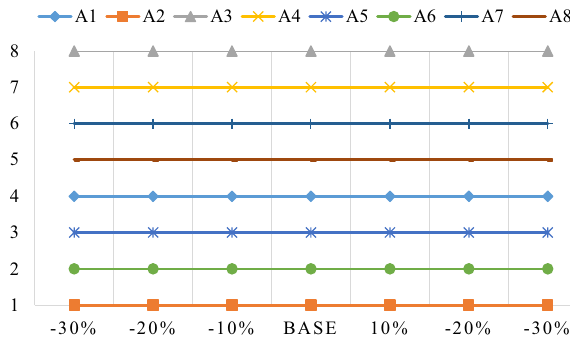
Figure 8. The comparison of the ranked orders of the